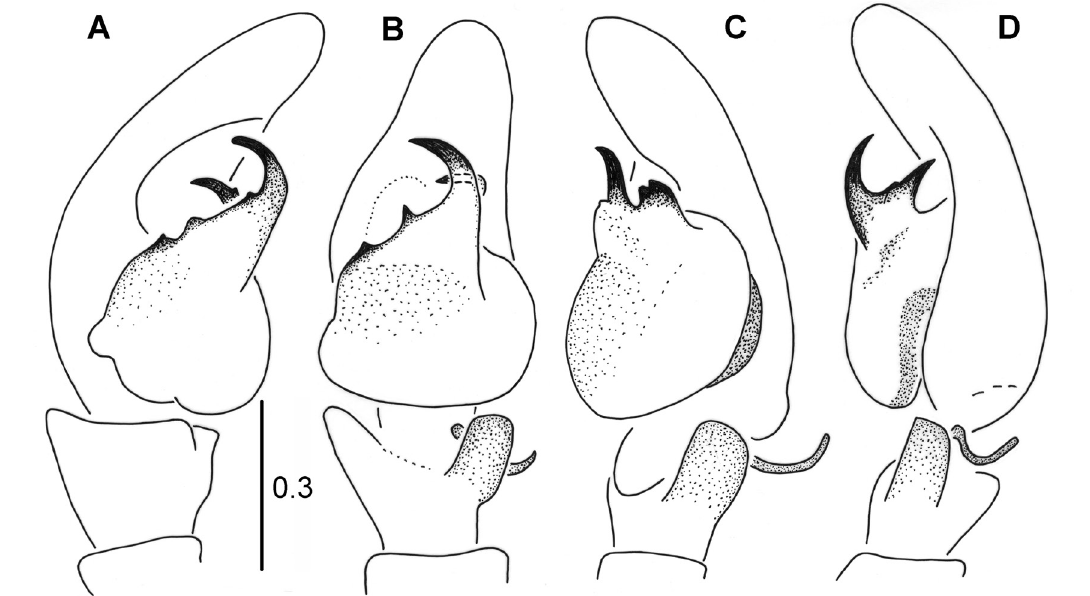
Fig. 54. Pochytoides tournieri sp. nov., holotype, ♂ (MNHN). A . Palpal organ, ventroprolateral view. B . Palpal organ, ventral view. C . Palpal organ, ventroretrolateral view. D . Palpal organ, retrolateral